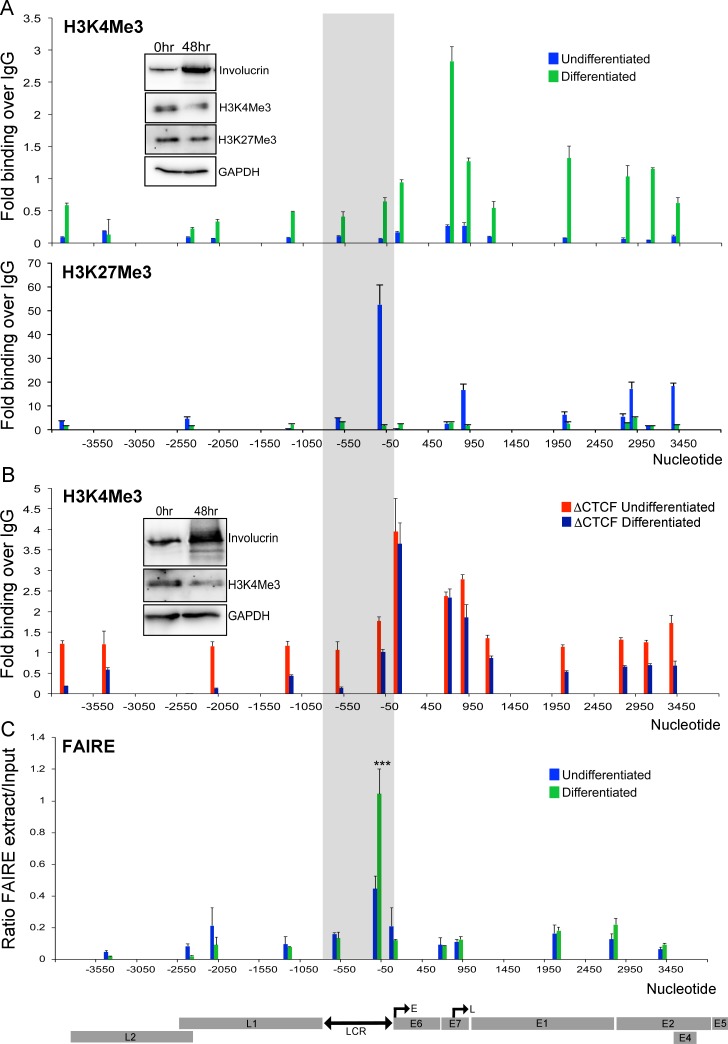
Host cell differentiation induces epigenetic switching and enhancer accessibility in HPV18 episomes.(A) Enrichment of H3K4Me3 (upper panel) and H3K27Me3 (lower panel) epigenetic marks was assessed in HPV18 episomes in undifferentiated (blue) and methylcellulose-differentiated (green) cells. Data show qPCR analysis at defined regions in the HPV18 genome as fold binding over IgG. The inset western blots show relative protein expression. (B) Enrichment of H3K4Me3 was assessed in ΔCTCF HPV18 episomes in undifferentiated (red) and methylcellulose-differentiated (purple) cells. The inset western blots show relative protein expression. (C) Chromatin accessibility following host cell differentiation was assessed by FAIRE. Data show qPCR analysis of amplicons in the HPV18 genome of FAIRE-extracted samples compared to Input in undifferentiated and differentiated HPV18 WT HFKs. The linearised HPV18 genome and CTCF–E2 ORF binding site are indicated. Data are represented as mean ± SD. (***p < 0.001). All raw quantitative data are enclosed in S1 Data. CTCF, CCCTC-binding factor; E, early promoter; FAIRE, formaldehyde-assisted isolation of regulatory elements; H3K4Me3, histone 3 lysine 4 trimethylation; H3K27Me3, histone 4 lysine 27 trimethylation; HPV, human papillomavirus; IgG, immunoglobulin G; L, late promoter; LCR, long control region; ORF, open reading frame; qPCR, quantitative PCR; WT, wild-type.